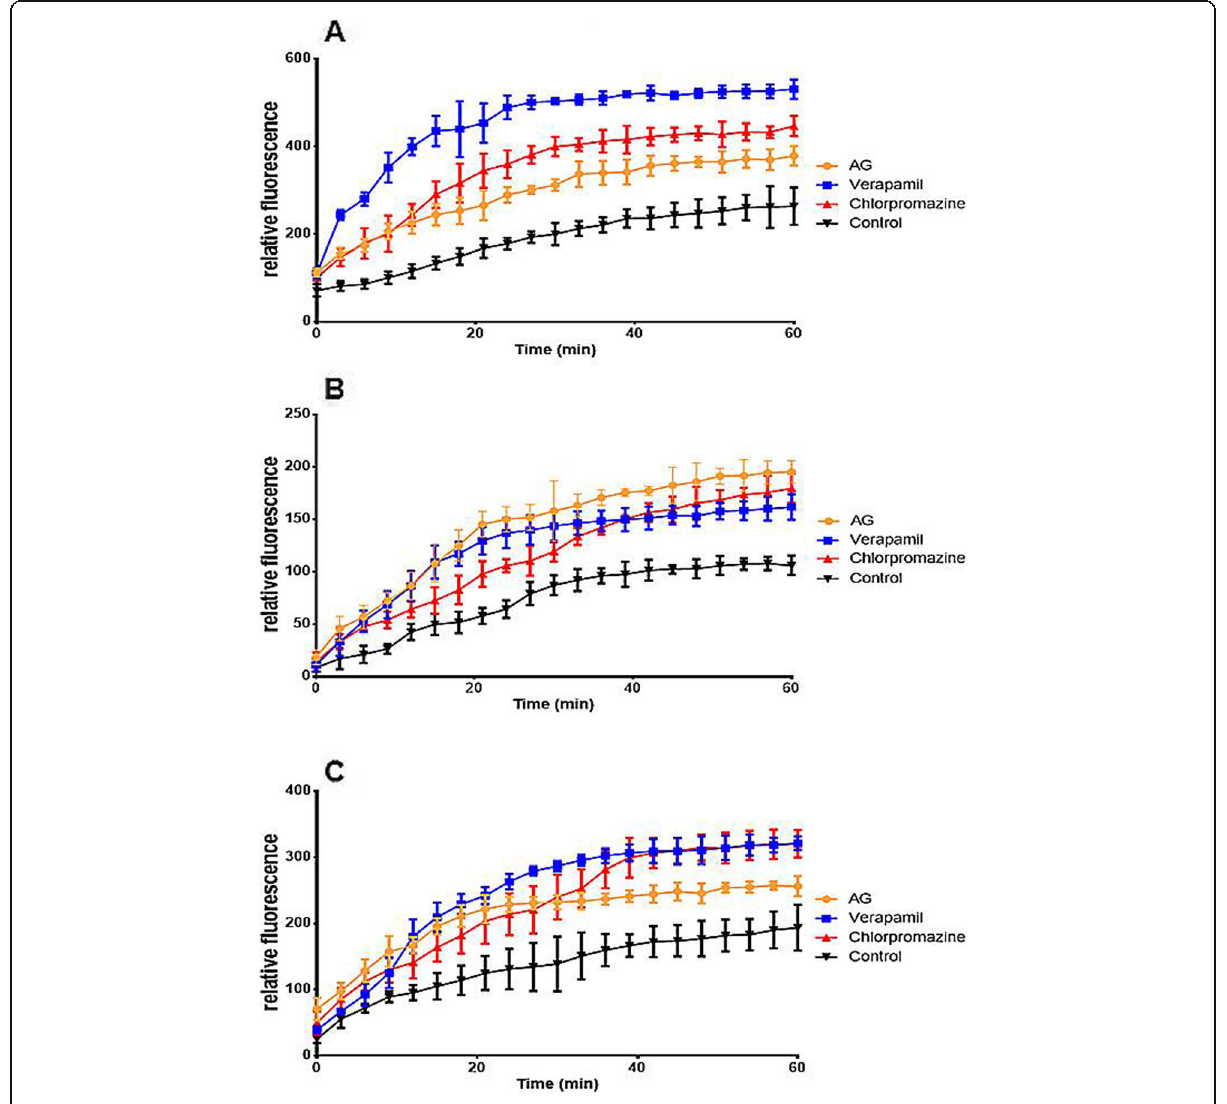
Fig. 4 Efflux pump inhibition effect of AG (½ MIC) in S. aureus (A), E. coli (B), P. aeruginosa